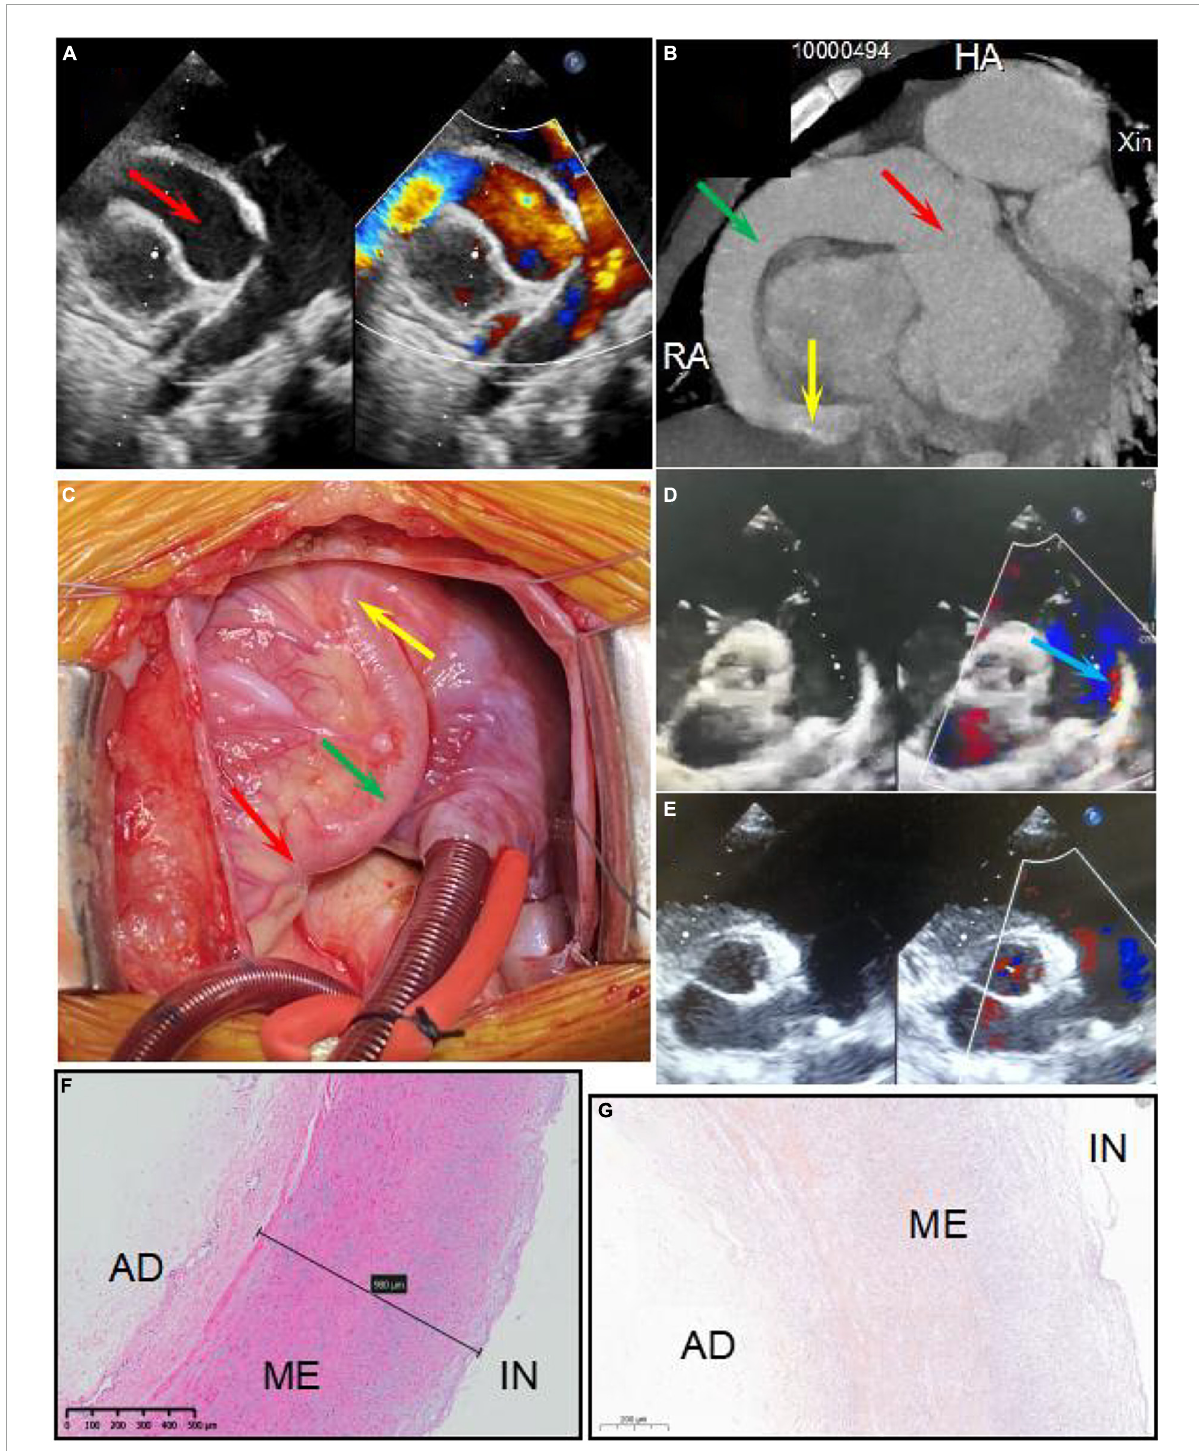
FIGURE1 Panels (A,B) show the right coronary artery fistula (RCAF) by echocardiogram and CT, respectively. Panel (C) shows the intraoperative photograph of the RCAF. The red arrow shows dilated ostium of RCA. The green arrow shows dilated the main stem of RCA. The yellow arrow shows the fistula. The blue arrow shows the patent ductus arteriosus (PDA). Panels (D,E) show the echocardiogram of PDA before surgery and after surgery, respectively. Panel (F) shows the HE staining of the excised coronary artery aneurysm. The structure of the coronary artery is almost normal. Panel (G) shows the negative calcium slats accumulation by Alizarin red staining of the excised coronary artery aneurysm. IN, intima; ME, media; AD,